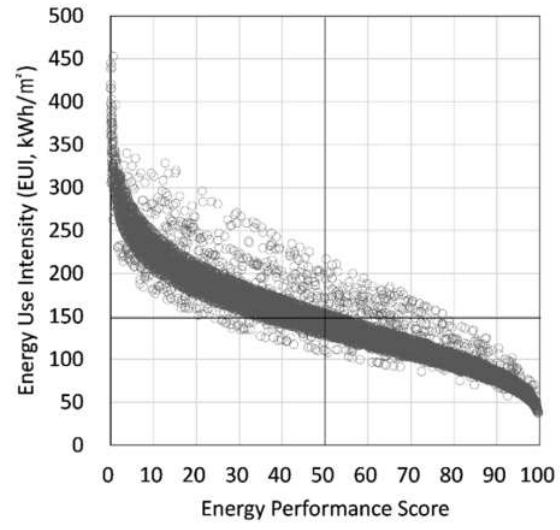
Figure 5. Energy performance score and EUI comparison.